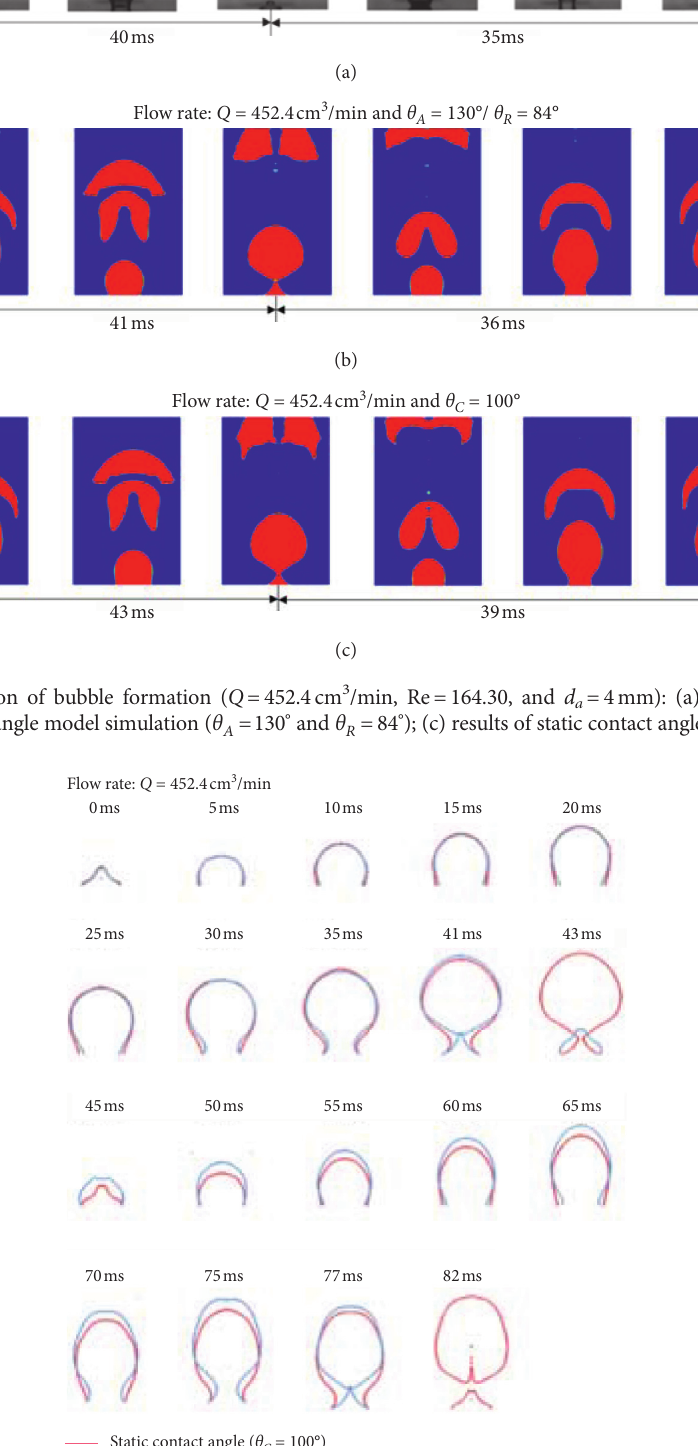
� 4mm). First bubble: a